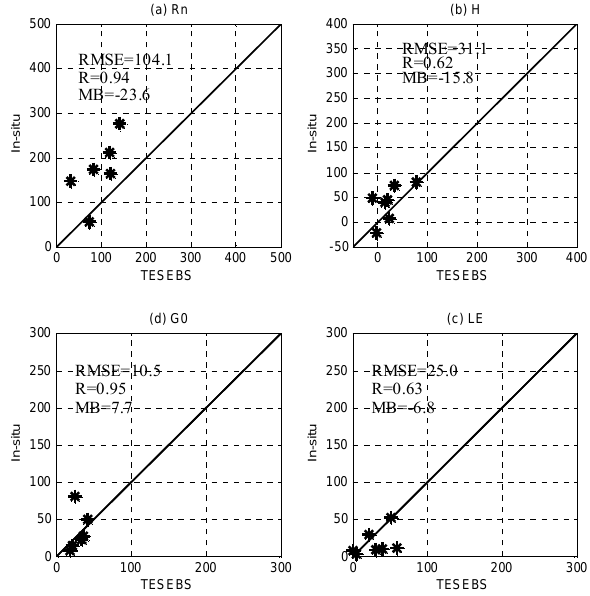
Fig. 4. Comparison of derived results with field measurements for Figure 4. Comparison of derived results with field measurements for the (a) net radiation (Rn, 864 the (a) net radiation ( R n , unit Wm − 2 ) , (b) sensible heat flux ( H , unit Wm − 2 ), (b) sensible heat flux (H, unit Wm − 2 ), (c) ground heat flux (G 0 , unit Wm − 2 ), (d) 865 unit Wm − 2 ) , (c) ground heat flux ( G 0 , unit Wm − 2 ) , (d) latent heat latent heat flux (LE, unit Wm − 2 ). 866 flux (LE, unit Wm − 2 )